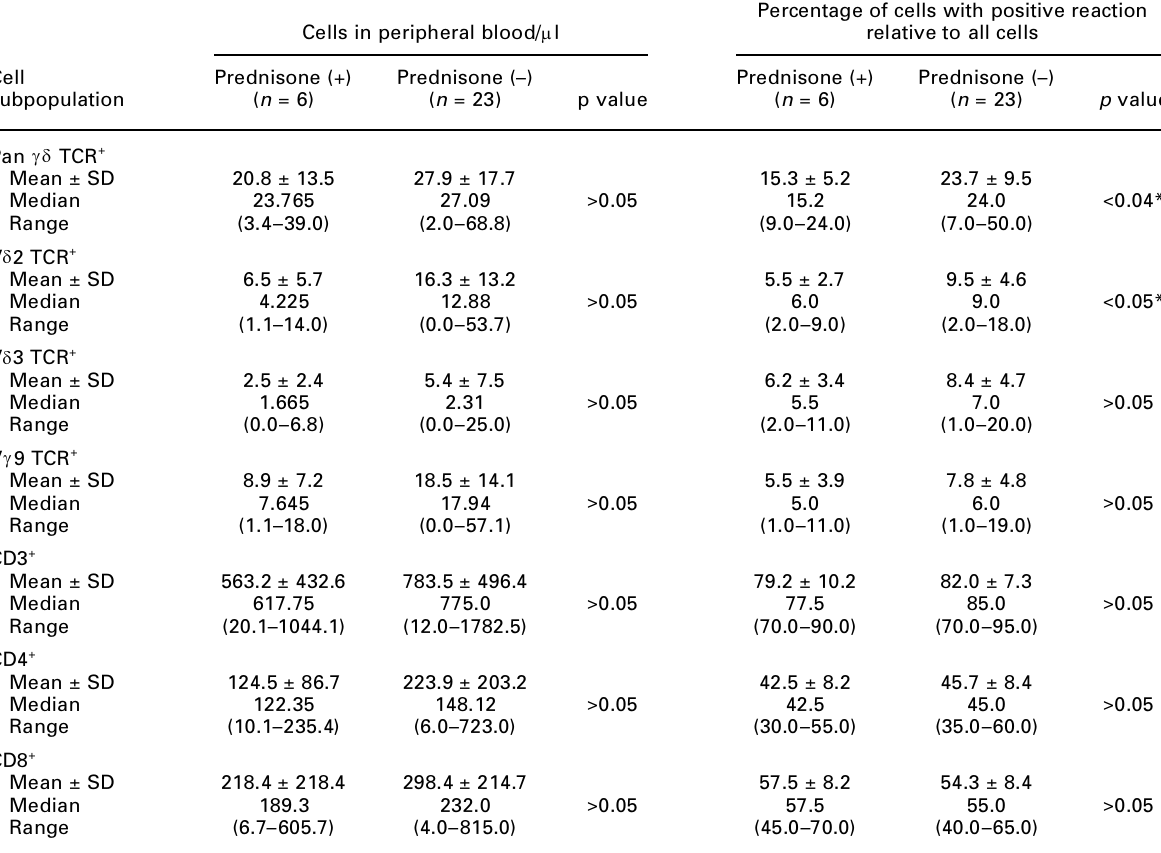
Table 4. g d T cells in peripheral blood and accumulation of g d T cells in clinically normal skin from SLE patients treated and not treated with prednisone during the study Cells in peripheral blood/ m l Cell Prednisone (+) Prednisone (–) subpopulation ( n = 6) ( n = 23) p value